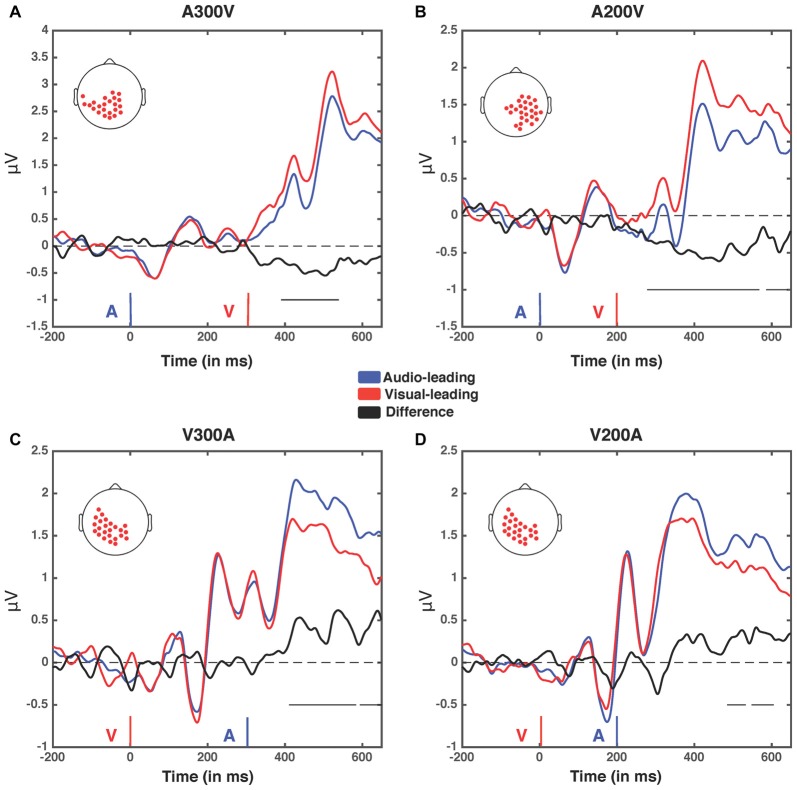
Event related potentials (ERPs) for the four spatiotemporal clusters. Electrodes contained within each cluster when it was at its largest spatial extent (in terms of number of electrodes) for the four greatest temporal disparities (A300V, A200V, V300A and V200A) were selected and voltage was averaged across them. The electrodes within the cluster in each condition are depicted by red dots on a scalp map (inset). Voltages when trial t−1 was an auditory lead are depicted in blue, while voltages when trial t−1 was a visual lead are depicted in red. The difference wave (audio-leading − visual-leading) is depicted in black. Onset of auditory (blue) and visual (red) stimuli are illustrated by vertical bars. Black horizontal bars at the bottom right of each panel indicate the temporal extent of significant clusters. (A) A300V—one significant cluster was found from 391 ms to 583 ms post-stimuli onset, p < 0.0001. (B) A200V—two significant clusters were found from 279 ms to 567 ms, p = 0.0002, and 587–640 ms, p = 0.0371. (C) V300A—two significant clusters were found from 412 ms to 583 ms, p = 0.0002, and 595–650 ms, p = 0.0147. (D) V200A—two significant clusters were found from 486 ms to 532 ms, p = 0.0394, and 549–604 ms, p = 0.0209. Note that electrodes averaged in this condition were selected from the V300A condition as the V200A condition did not produce a significant cluster.